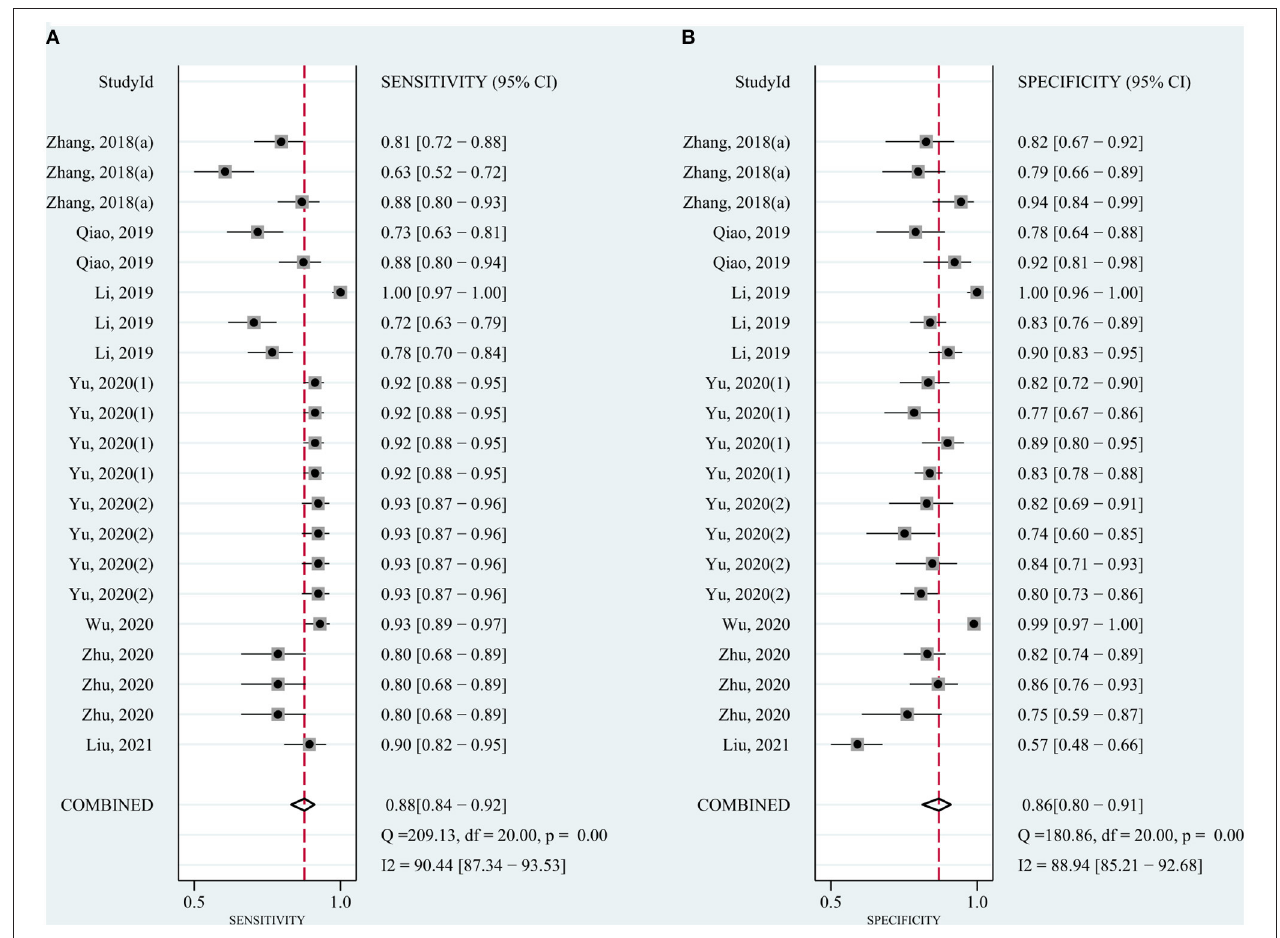
FIGURE 5 | Forest plots for sensitivity and specificity of the combination of circRNAs and AFP in